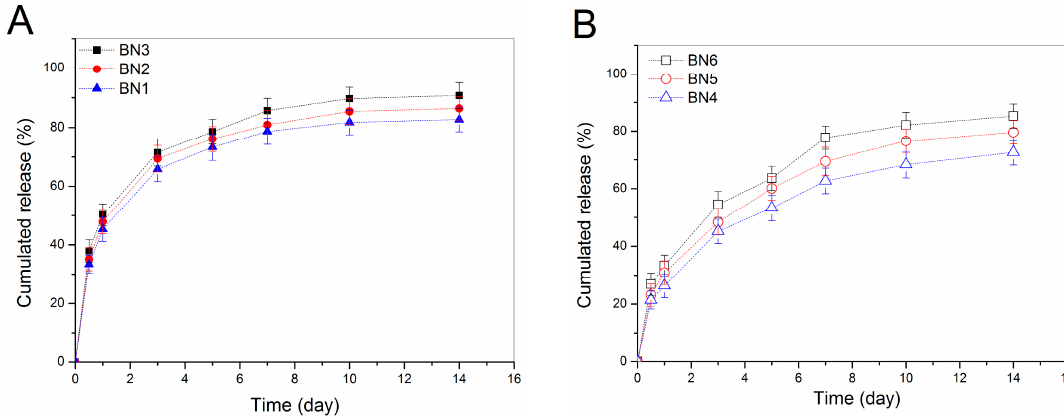
Figure 5. Release profiles for BMP-2-encapsulated HA/CH NPs ( A ) and for